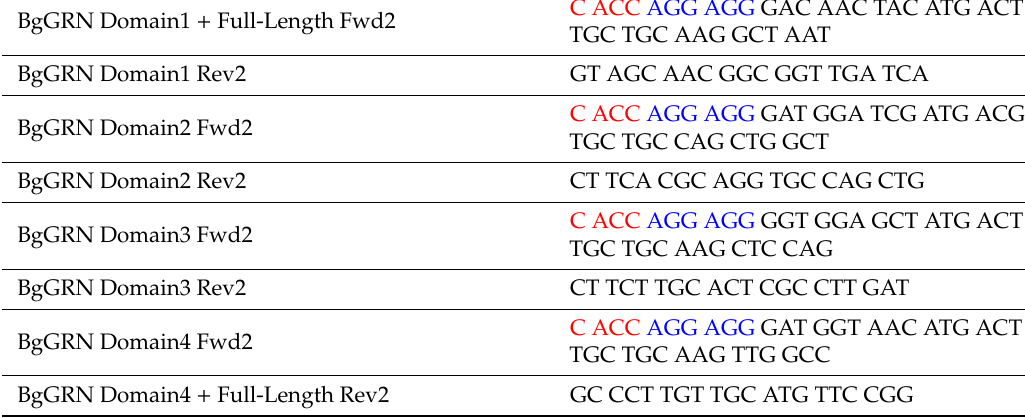
Table 1. List of primers used to generate full-length BgGRN, as well as its intermediate 2 and 3 granulin domain-containing intermediates. Red sequences indicate nucleotide additions necessary to directionally insert the PCR product into pENTR / D-TOPO, while blue sequences denote added ribosome-binding